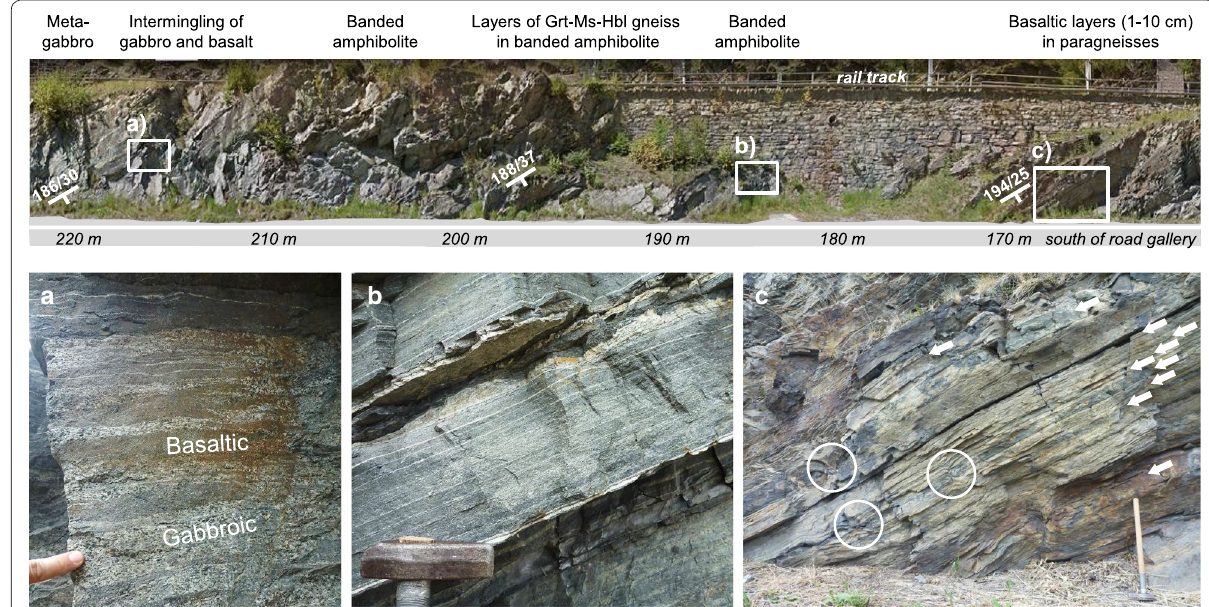
Fig. 5 Road cut through the 200 m thick banded amphibolite formation south of the Sassella gallery (Silvretta Nappe, 4.5 km north of Zernez; Swiss coordinates: 2 ʹ 801 ʹ 778/1 ʹ 179 ʹ 591). Three details ( a – c ) are located within the sector 220–160 m distance from the gallery: a Intermingling of basaltic schollen in a gabbroic matrix at 216 m south of Sassella gallery. b Banded amphibolite at 184 m south of Sassella gallery. c Swarm of basaltic dykes at 168 m south of Sassella gallery. Each dyke is indicated by an arrow. Some are locally boudinaged (indicated by circles)